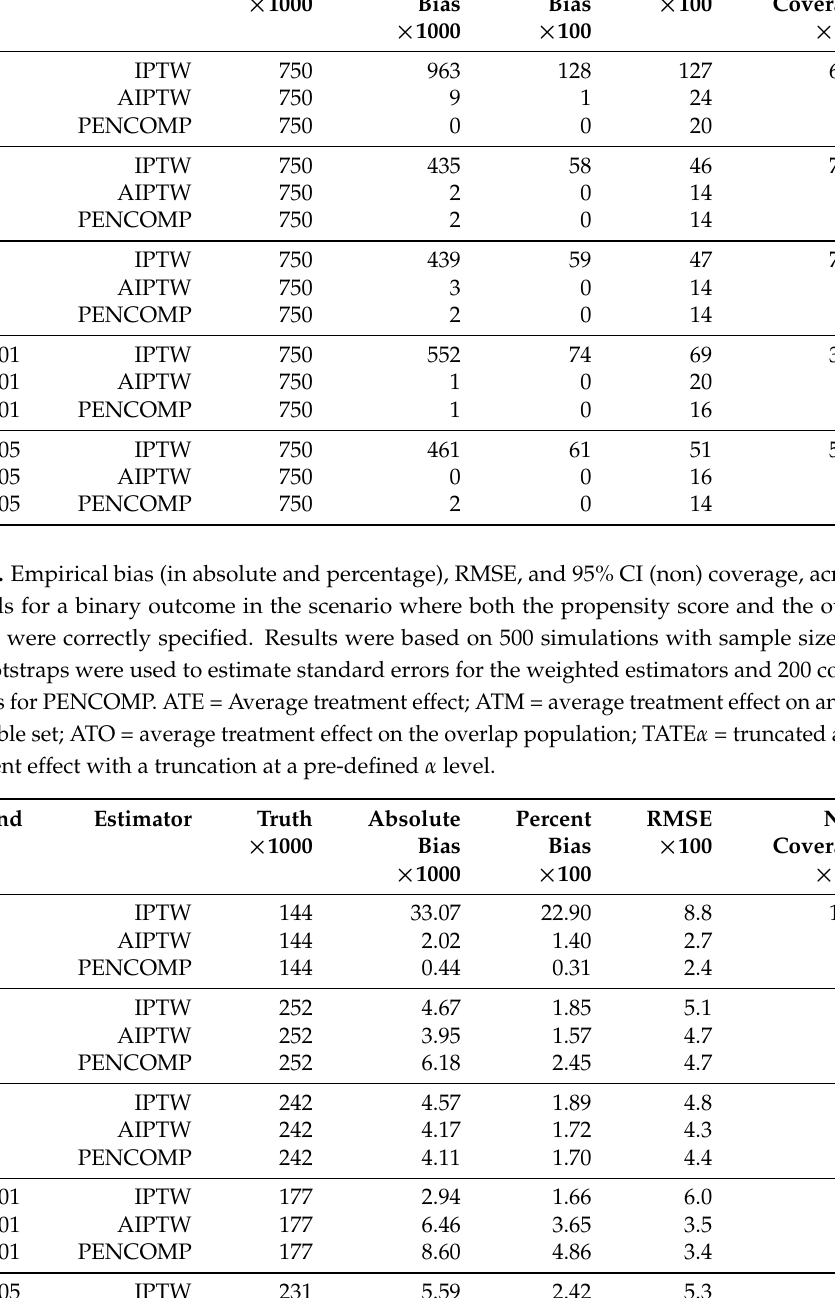
Table 3. Empirical bias (in absolute and percentage), RMSE, and 95% CI (non) coverage, across the methods in a linear and continuous outcome model for the scenario where the propensity score models were misspecified. Results were based on 500 simulations with sample size of 500; 500 bootstraps were used to estimate standard errors for the weighted estimators and 200 complete datasets for PENCOMP. ATE = Average treatment effect; ATM = average treatment effect on an evenly matchable set; ATO = average treatment effect on the overlap population; TATE α = truncated average treatment effect with a truncation at a pre-defined α level. Estimand